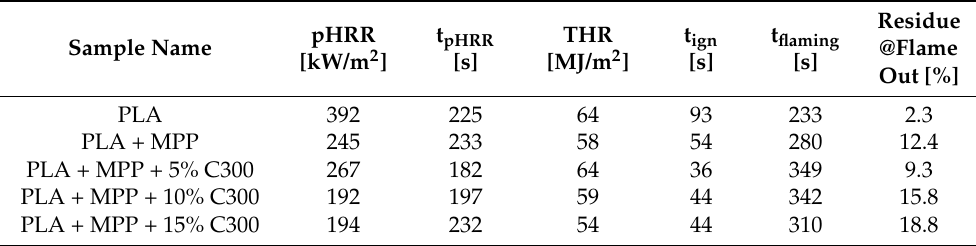
Table 5. Average mass loss calorimetry results of the composite samples with different neat cellulose content.